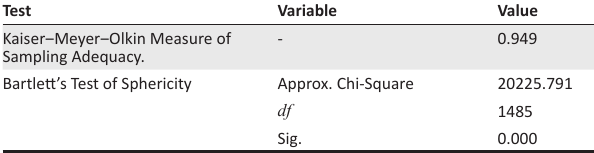
TABLE 3: Kaiser‒Meyer‒Olkin and Bartlett’s